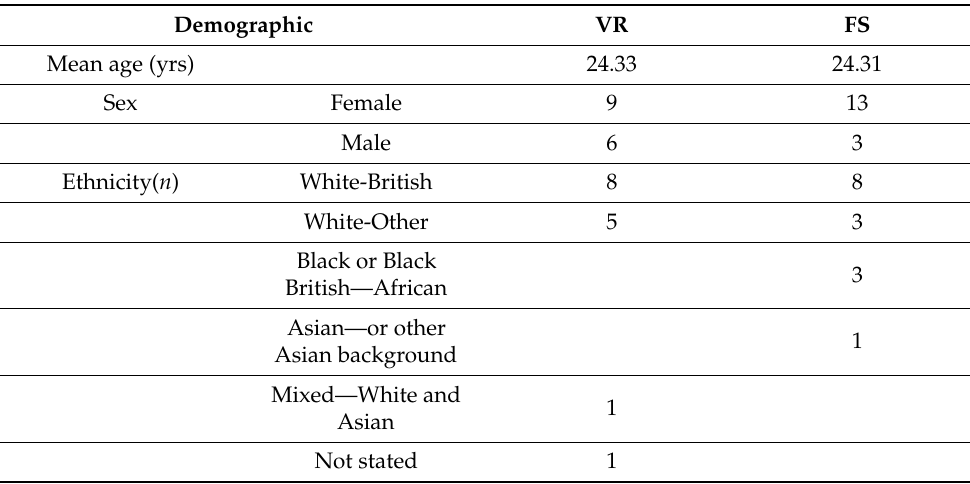
Table 1. Participant demographics per